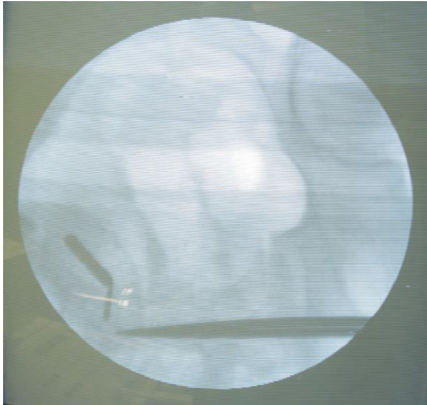
Figure 2: Intraoperative X-ray evidenced 2 magnets in the ileum.